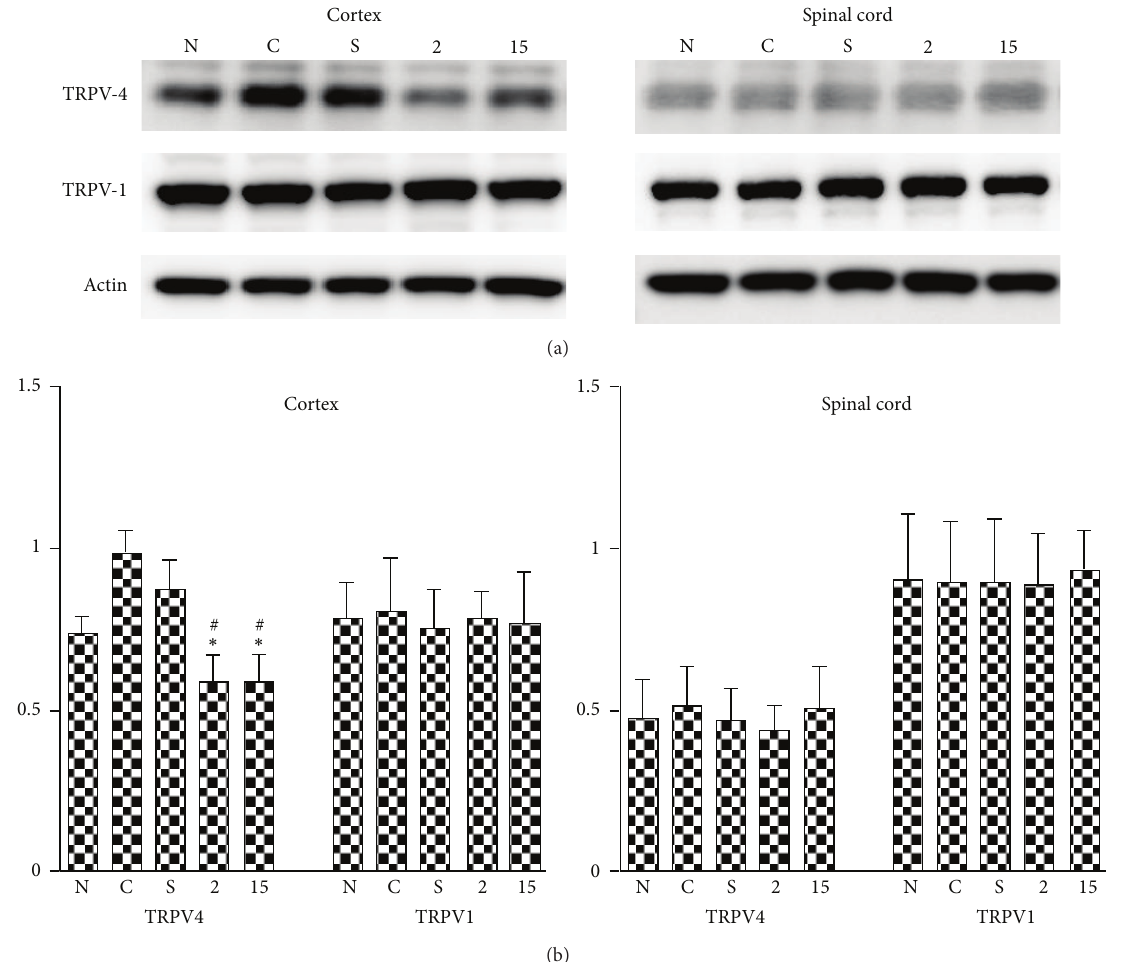
Figure 1: Effect of EA on TRPV4 and TRPV1 in CCI-induced neuropathic pain. TRPV4 expression in the cerebral cortex (cortex) increased in the control group without treatment (C), and these increases were reduced by 2 Hz (2) and 15 Hz (15) EA treatments at right St-36 (a) and St-37 (b) acupoints, respectively, whereas the differences in TRPV1 expressions were nonsignificant among the normal (N), C, S (sham), 2, and 15 groups (a and b). Differences in the level of TRPV4 and TRPV1 expressed in the spinal cord (Spinal cord) among the N, C, S, 2, and 15 groups (a and b) were non-significant; normal = normal group; control = control group; sham = sham group; 2EA = 2EA group; 15EA = 15EA group; ∗ 𝑃 < .01 compared to C; # 𝑃 < .01 compared to